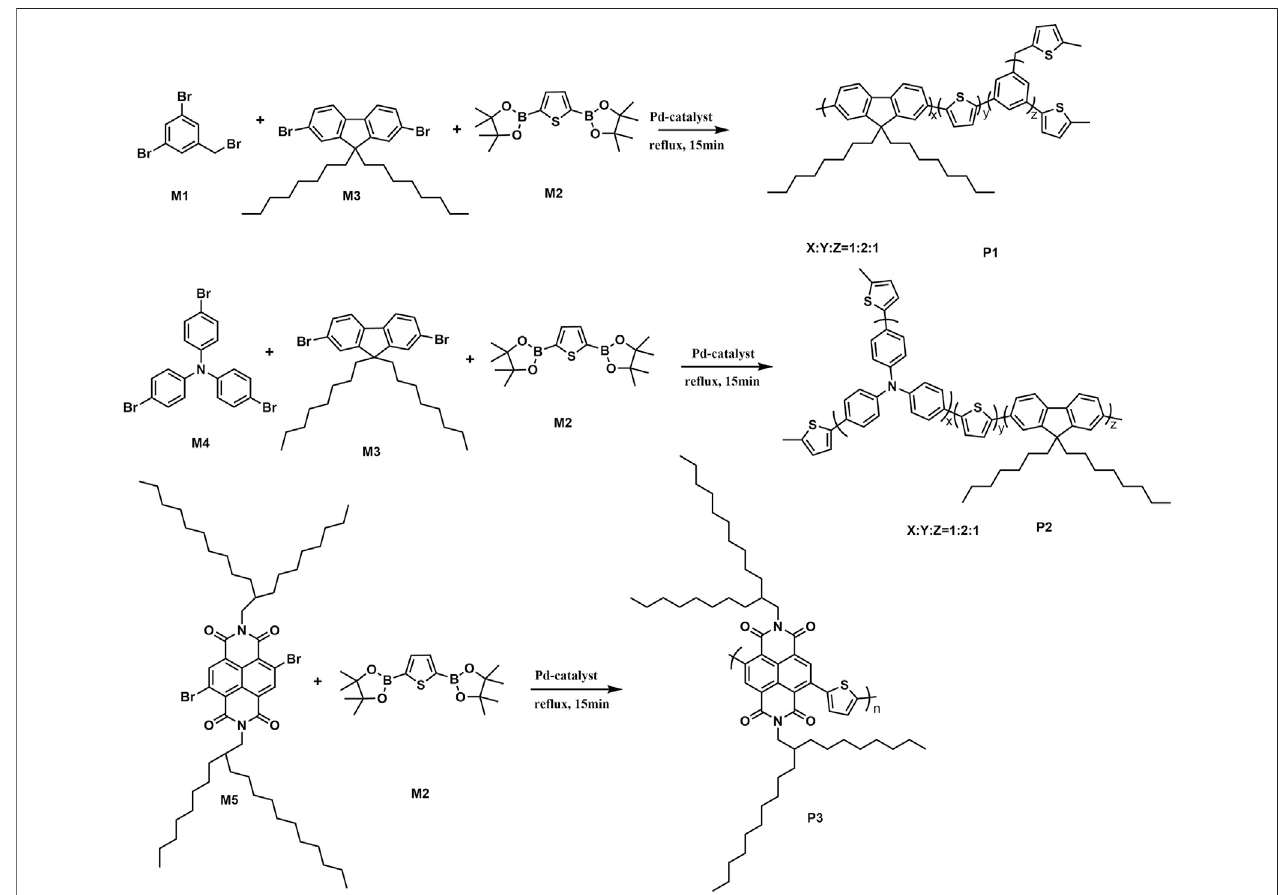
TABLE 3 | Catalyst precursor, yield, weight-average molecular weight ( M w), and polydispersity index (PDI). Polymers Catalyst precursor Yield (%) M w a (g mol − 1 )